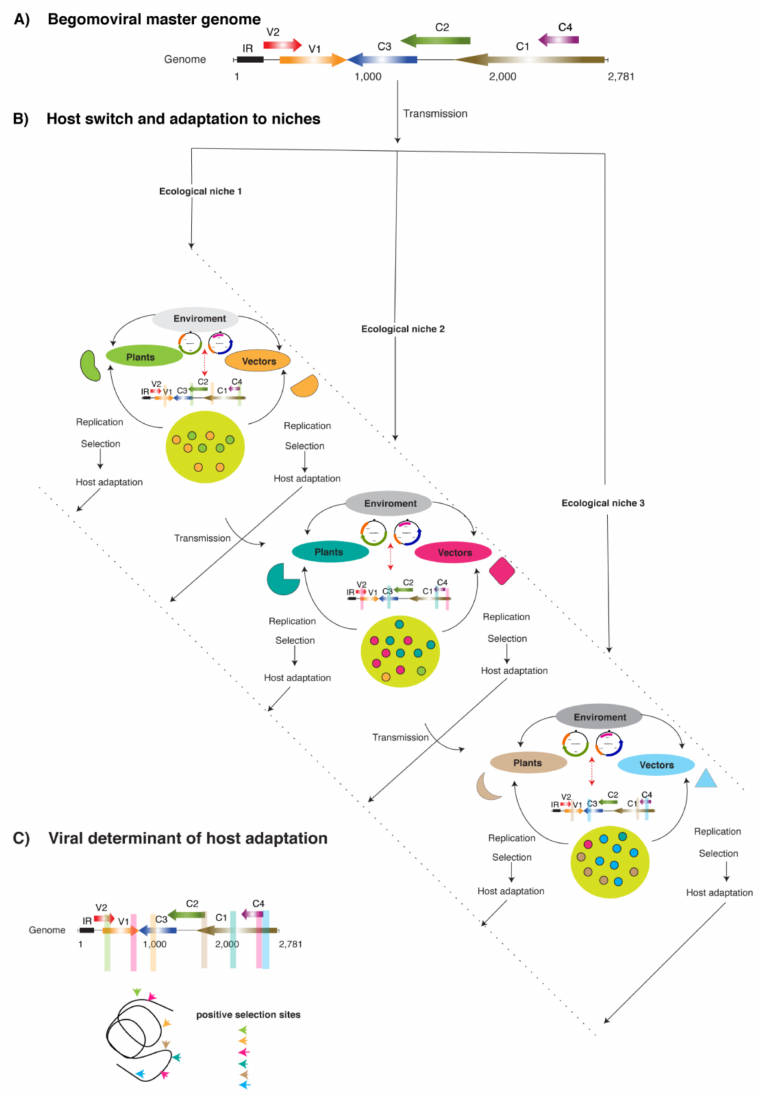
Figure 1. Model for Begomoviral genomic diversity and adaptation. ( A ) A Begomoviral master genome. Begomovirus (BGVs) encodes 6–7 proteins (V2 and V1) from the sense strand and C3, C2, C1, and C4 in the antisense strand. ( B ) BGVs may be transmitted by their vector ( B. tabaci )